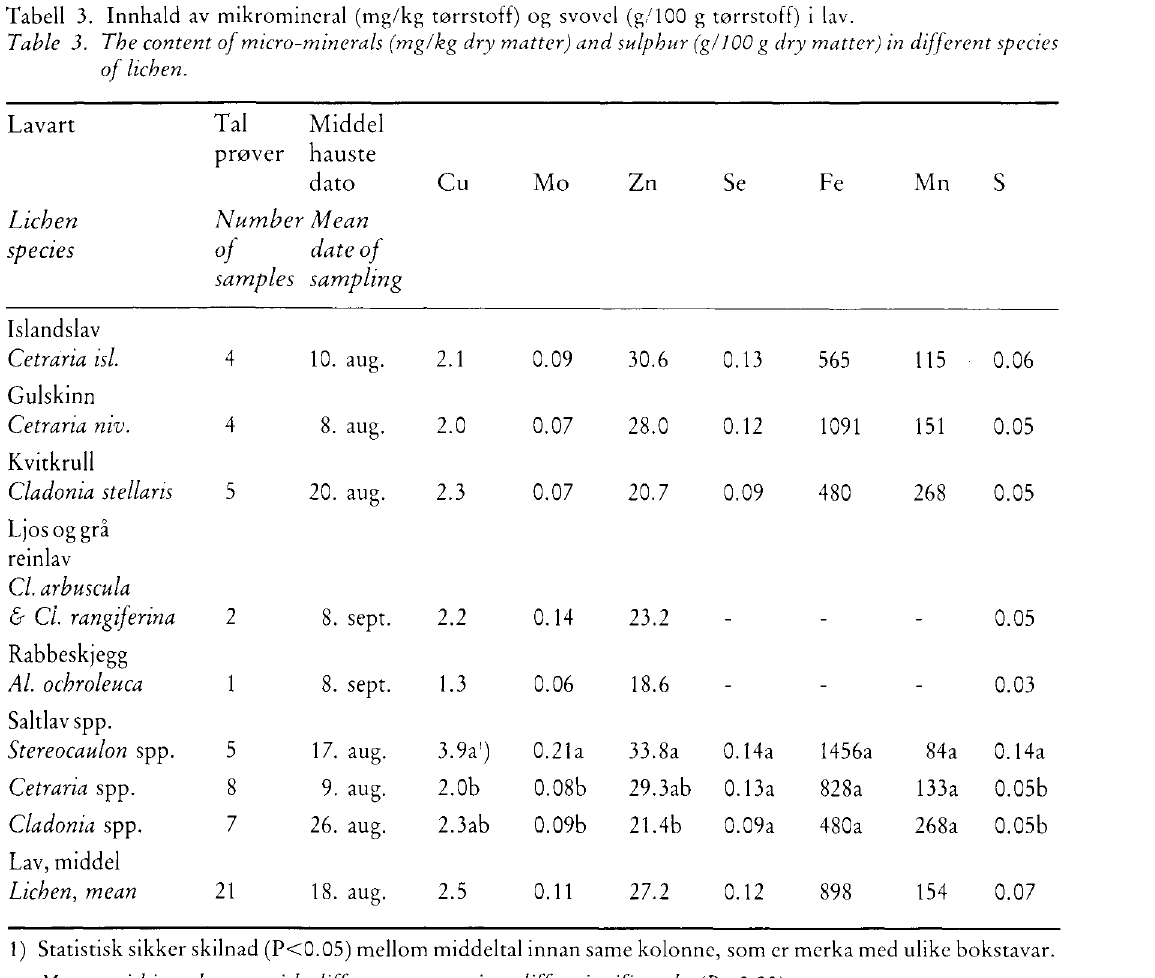
Table 3. The content of micro-minerals (mg/kg dry matter) and sulphur (g/100 g dry matter) in different species of lichen. Lavart Tal prøver